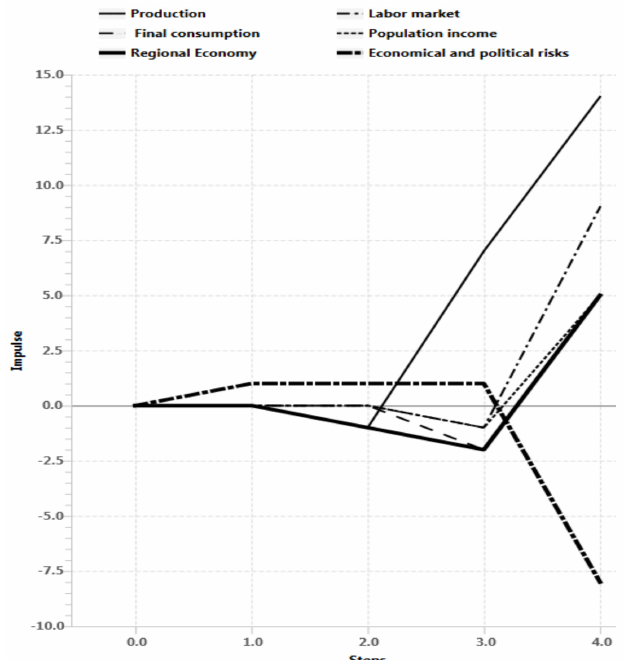
Figure 14. The graph of impulse processes at the selected vertices V1–V5, V16 Scenario "Improving the conditions of higher education and economical and political risks increasing, while federal regulatory